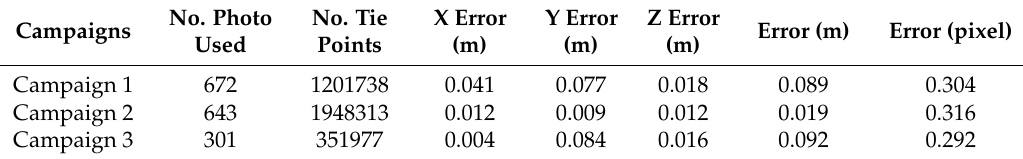
Figure 6. Histograms of errors of images georeferencing from GCPs for ( a ) campaign 1; ( b ) campaign 2; and ( c ) campaign 3. Table 3. Assessment of the image georeferencing error from GCPs for the three campaigns.